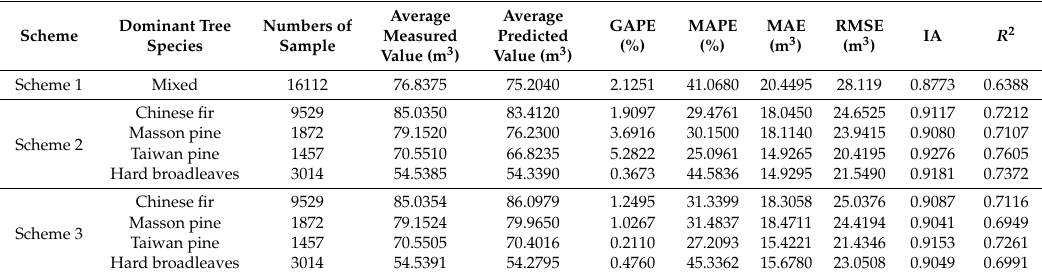
Table 4. Detailed performance metrics of the modeling results for each scheme.